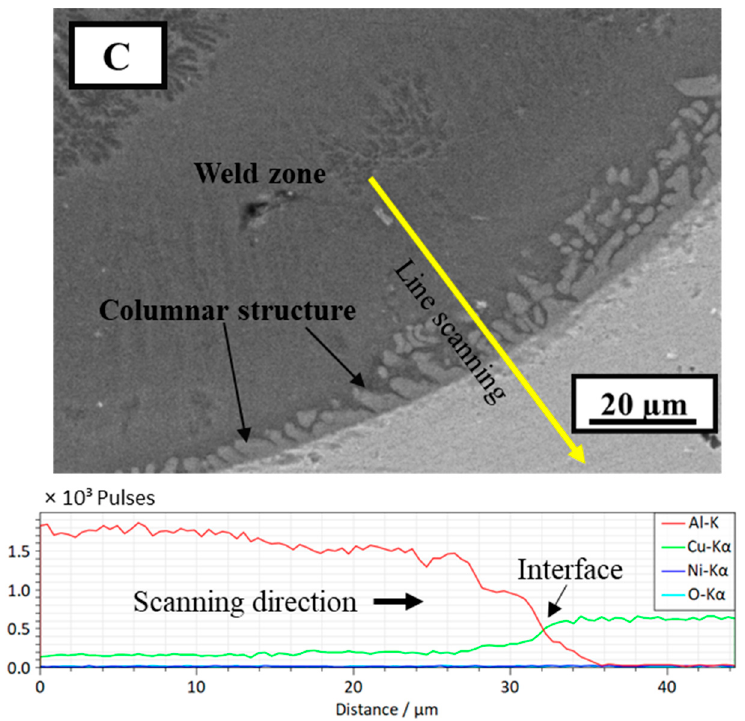
magnified SEM images of microstructures at location A, B and C in weld fusion zone, respectively.